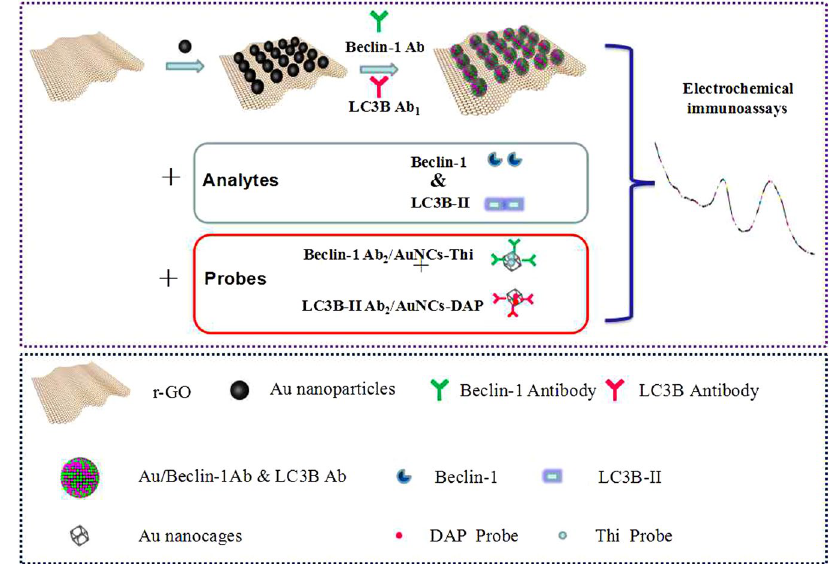
Figure 1. Preparation and schematic illustration of the electrochemical immunoassay